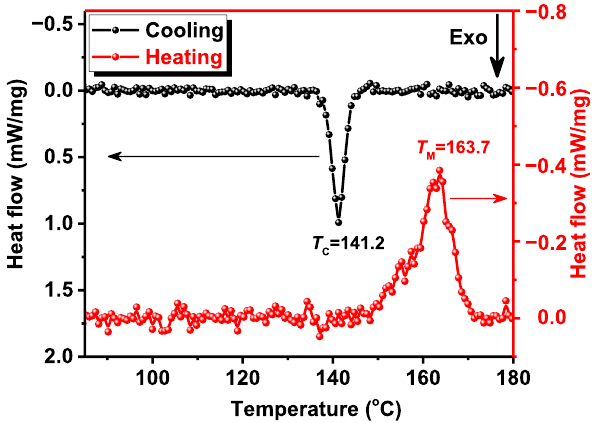
Figure 4. DSC thermographs of PVDF/BFO